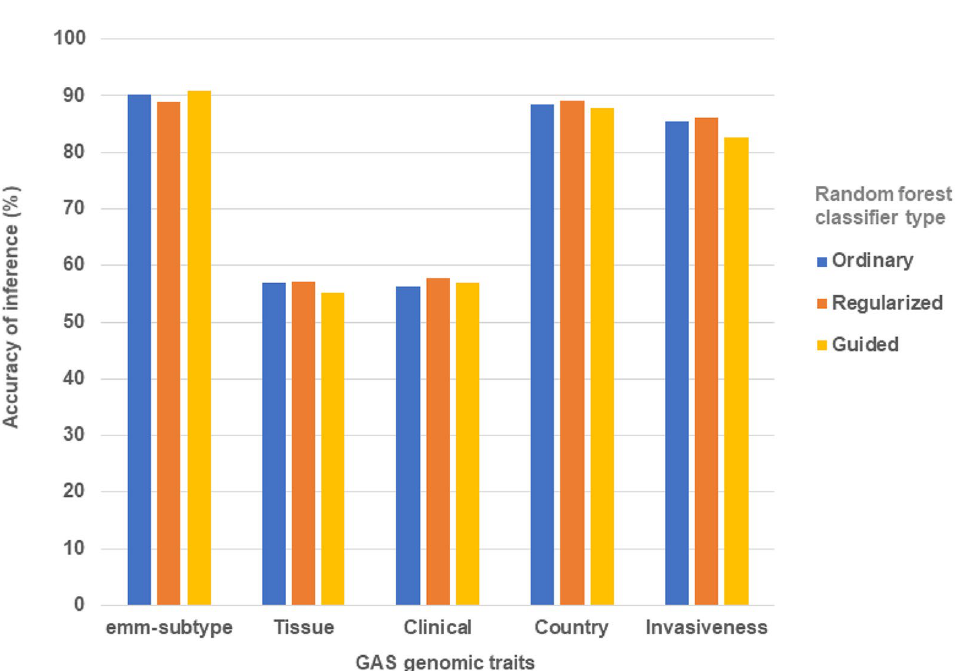
Figure 7. Accuracy of the random forest classifiers tested in inferring group A Streptococcus genomic traits from a selection of 53 response regulator allele types. The labels tested include emm -subtype, the tissue and country from which the isolate was sampled, clinical outcomes from the infection, and the propensity of the isolate to cause invasive